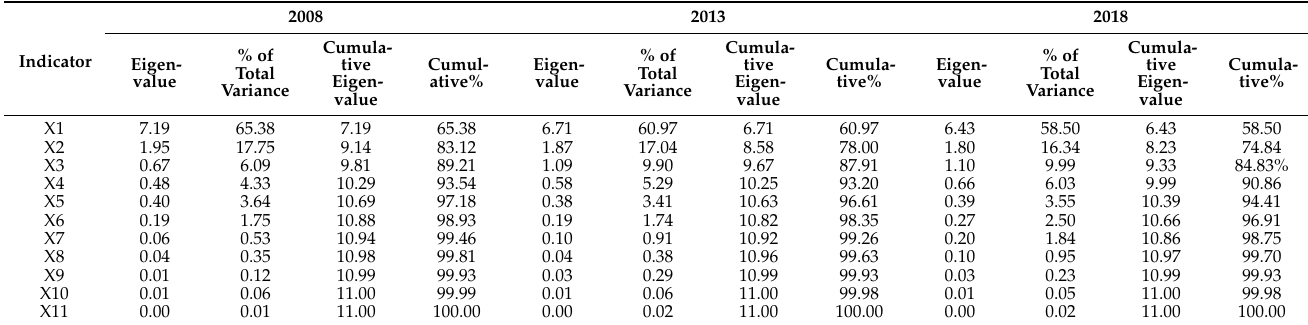
Table 8. Eigenvalues of the correlation matrix.